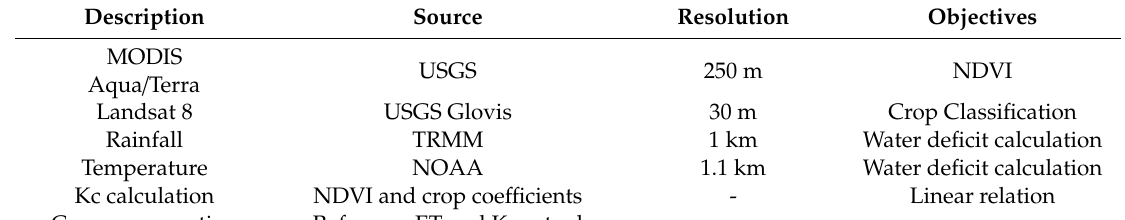
Table 1. Description of datasets.